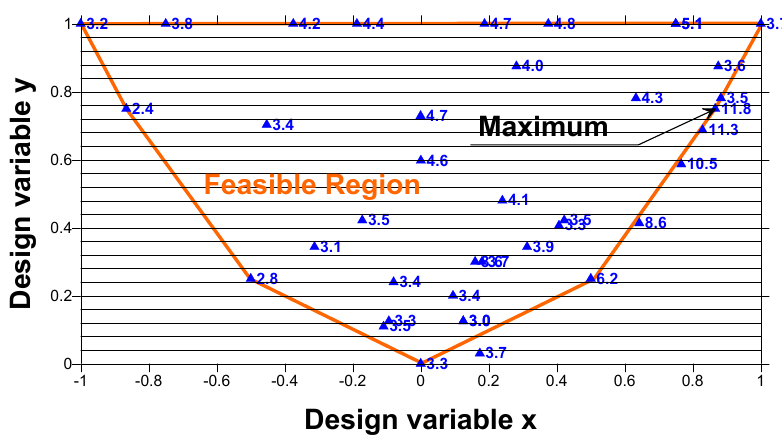
Figure 5. Post map of buckling loads in kPa—the square plate with the circular hole (2 b / L x = 0.4); the orange lines denote the polygon for seven discrete fibre orientations.